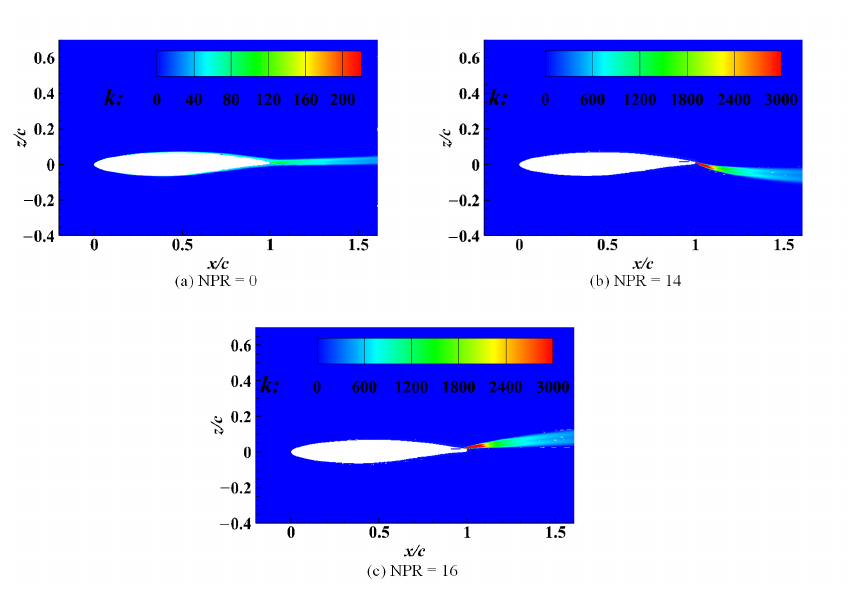
Figure 20. Entrainment characteristics with increasing NPR ( Ma = 0.3).